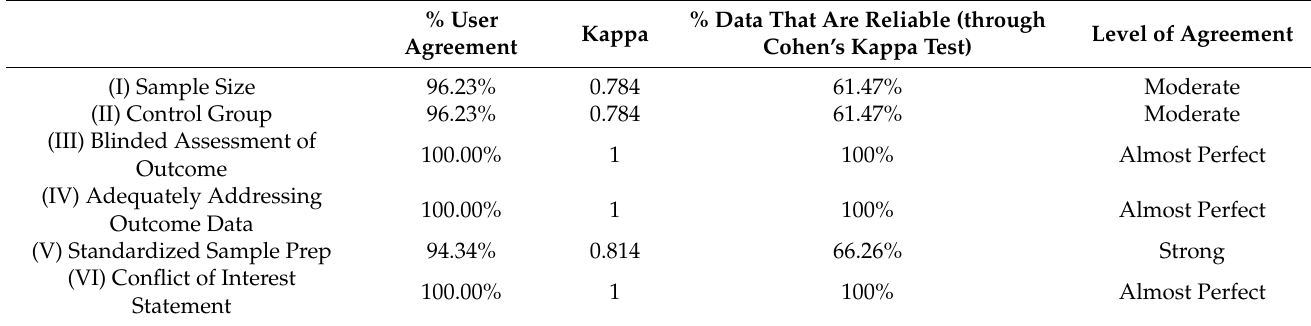
Table 4. IRR Values of Studies in the Systematic